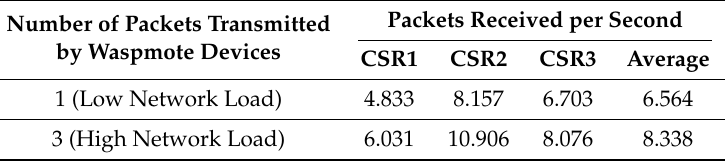
Table 9. Packets per second received by CSR devices when they retransmit each packet 3 times (default mode). Waspmote devices configured as Individual Mesh